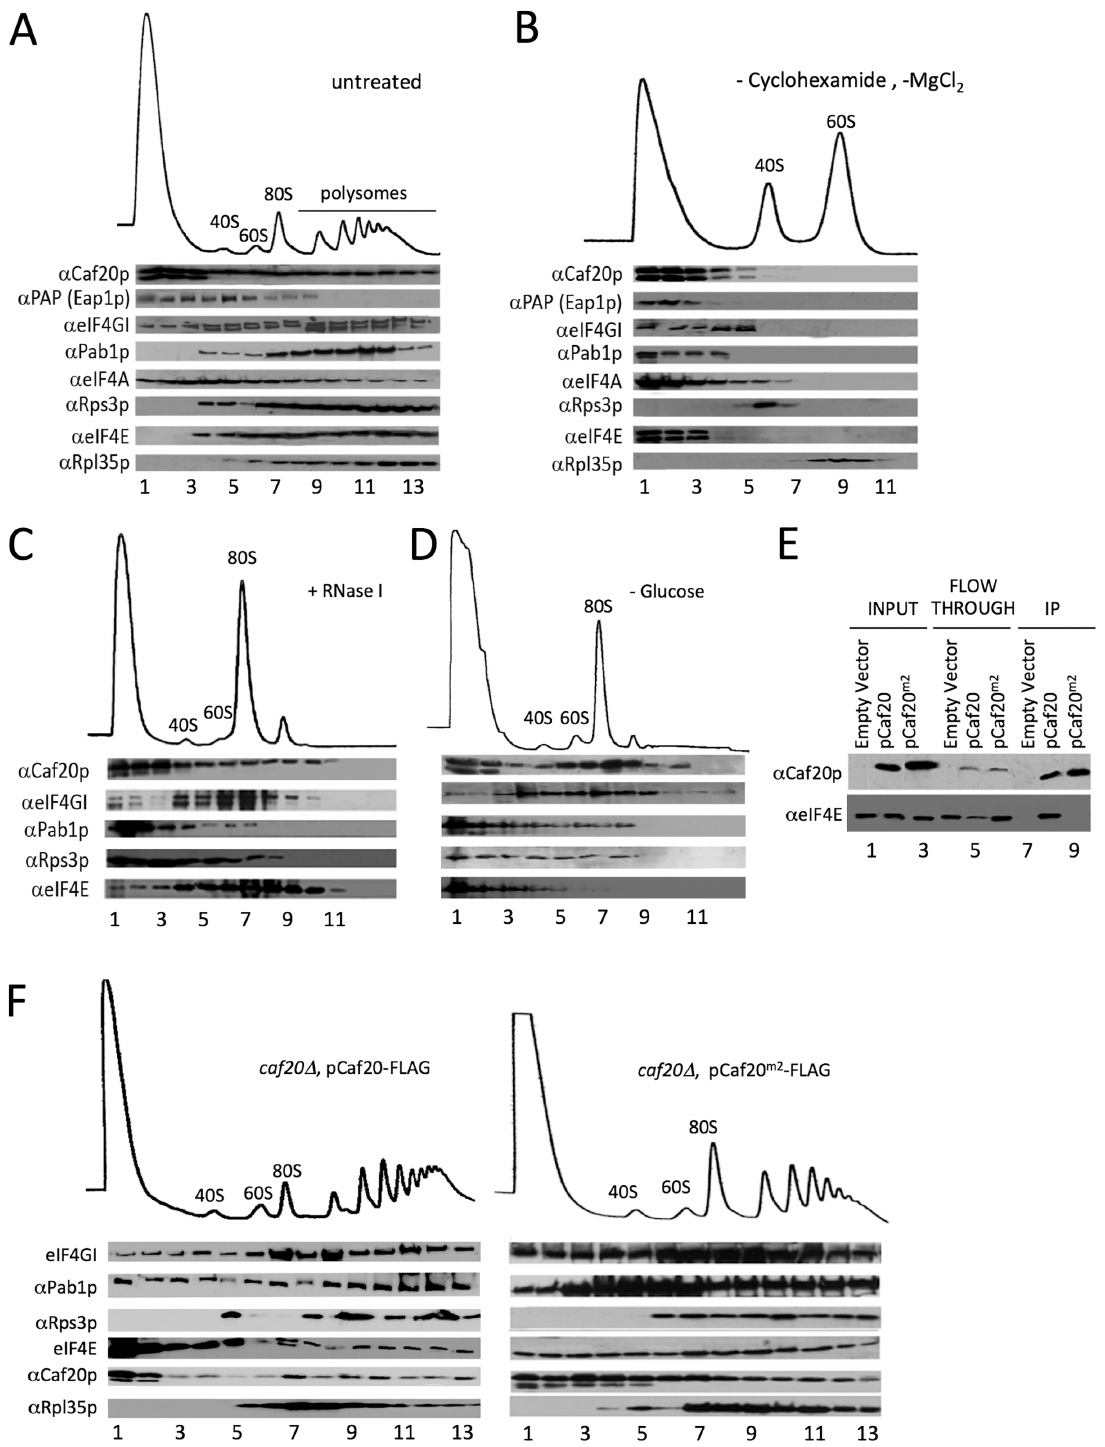
Fig 2. 4E-BPs associate with translating ribosomes in an eIF4E-independent manner. A. Sucrose density gradient analysis of extracts from the Eap1-TAP strain. Fractions were collected and protein distribution across the gradients visualised with western blots. Blots were probed for the 4E-BPs, closed loop components and 40S/60S ribosomal subunits. B. Western blot analyses of fractions collected from sucrose density gradients of extracts from the Eap1-TAP strain. The 80S ribosomal complex was dissociated by removal of cycloheximide and MgCl 2 from the lysis buffer. Blots were probed for the 4E-BPs, closed loop components and 40S/60S ribosomal subunits. C. Western blot analysis of fractions collected from a sucrose density gradient of